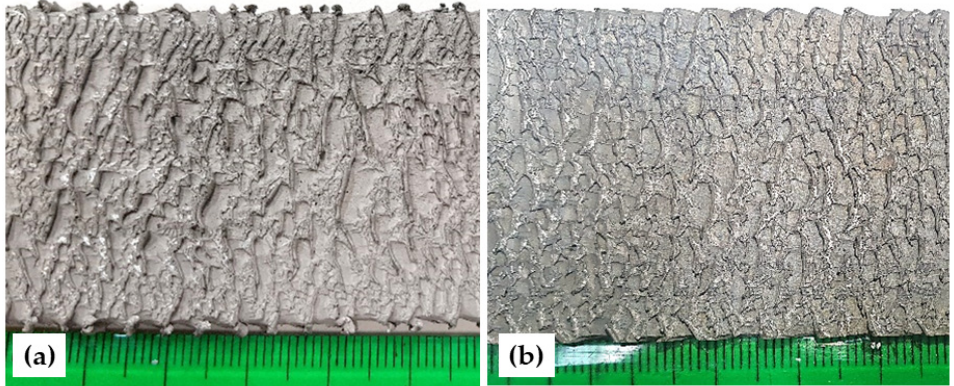
Figure 12. Surface appearance of the extruded profiles of ( a ) 7075-1 wt.% MWCNT and ( b ) 7075-0.5 wt.% MWCT showing intense hot tearing.